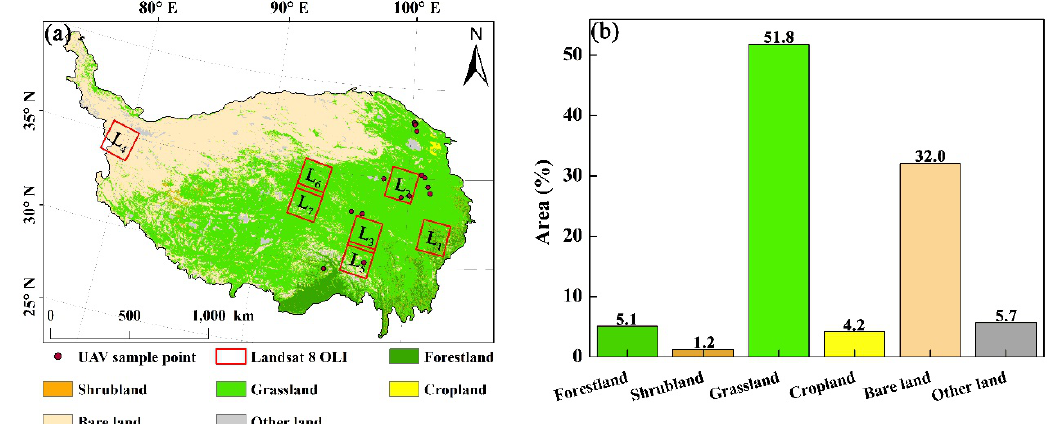
Figure 1. ( a ) UAV sampling points with the footprint of the Landsat 8 OLI images used in this study and the land cover types (MCD12Q1) [32], and ( b ) proportions in the Tibetan Plateau (TP).